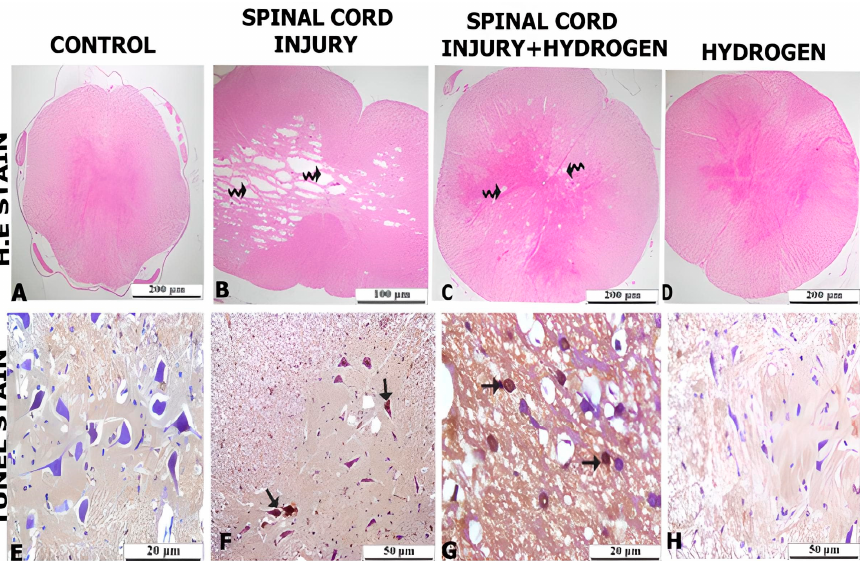
Figure 1. Histopathologic findings in spinal cord tissue. ( A ) Control group spinal cord H & E staining (bar: 200 µm). ( B ) Spinal cord injury group, curved arrow (bar: 100 µm). H & E staining of damaged lesion areas. ( C ) Spinal cord injury + hydrogen group, curved arrow: H & E staining of damaged lesion areas (bar: 200 µm). ( D ) Hydrogen group: H & E staining (bar: 200 µm). ( E ) Control group: terminal TUNEL staining (bar: 50 µm). ( F ) Spinal cord injury group: TUNEL staining, normal arrow, positive cells normal arrow gray matter: TUNEL-positive neurons in spinal cord–damaged group; TUNEL staining arrow (bar: 50 µm). ( G ) Spinal cord injury + hydrogen group: TUNEL staining (bar: 50 µm), normal arrow TUNEL-positive cells. ( H ) Hydrogen group: TUNEL staining (bar: 50 µm).